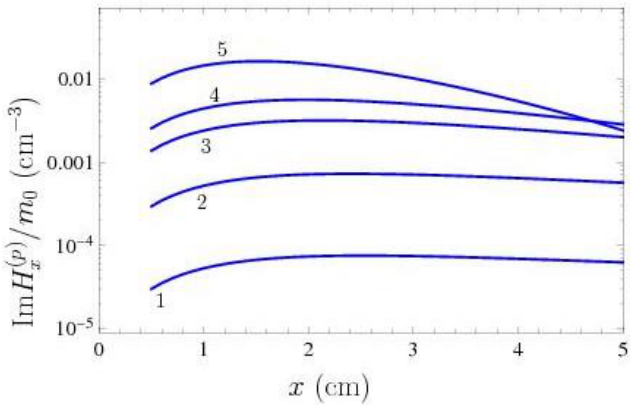
Figure 3. The normalized imaginary part of the lateral component of monochromatic magnetic field reflected from the copper plate computed using the Drude model as the function of separation from the magnetic dipole at the dipole height of 1 cm above a plate is shown by the solid lines labeled 1, 2, 3, 4, and 5 for the oscillation frequency equal to 0.2, 2, 10, 20, and 100 rad/s,